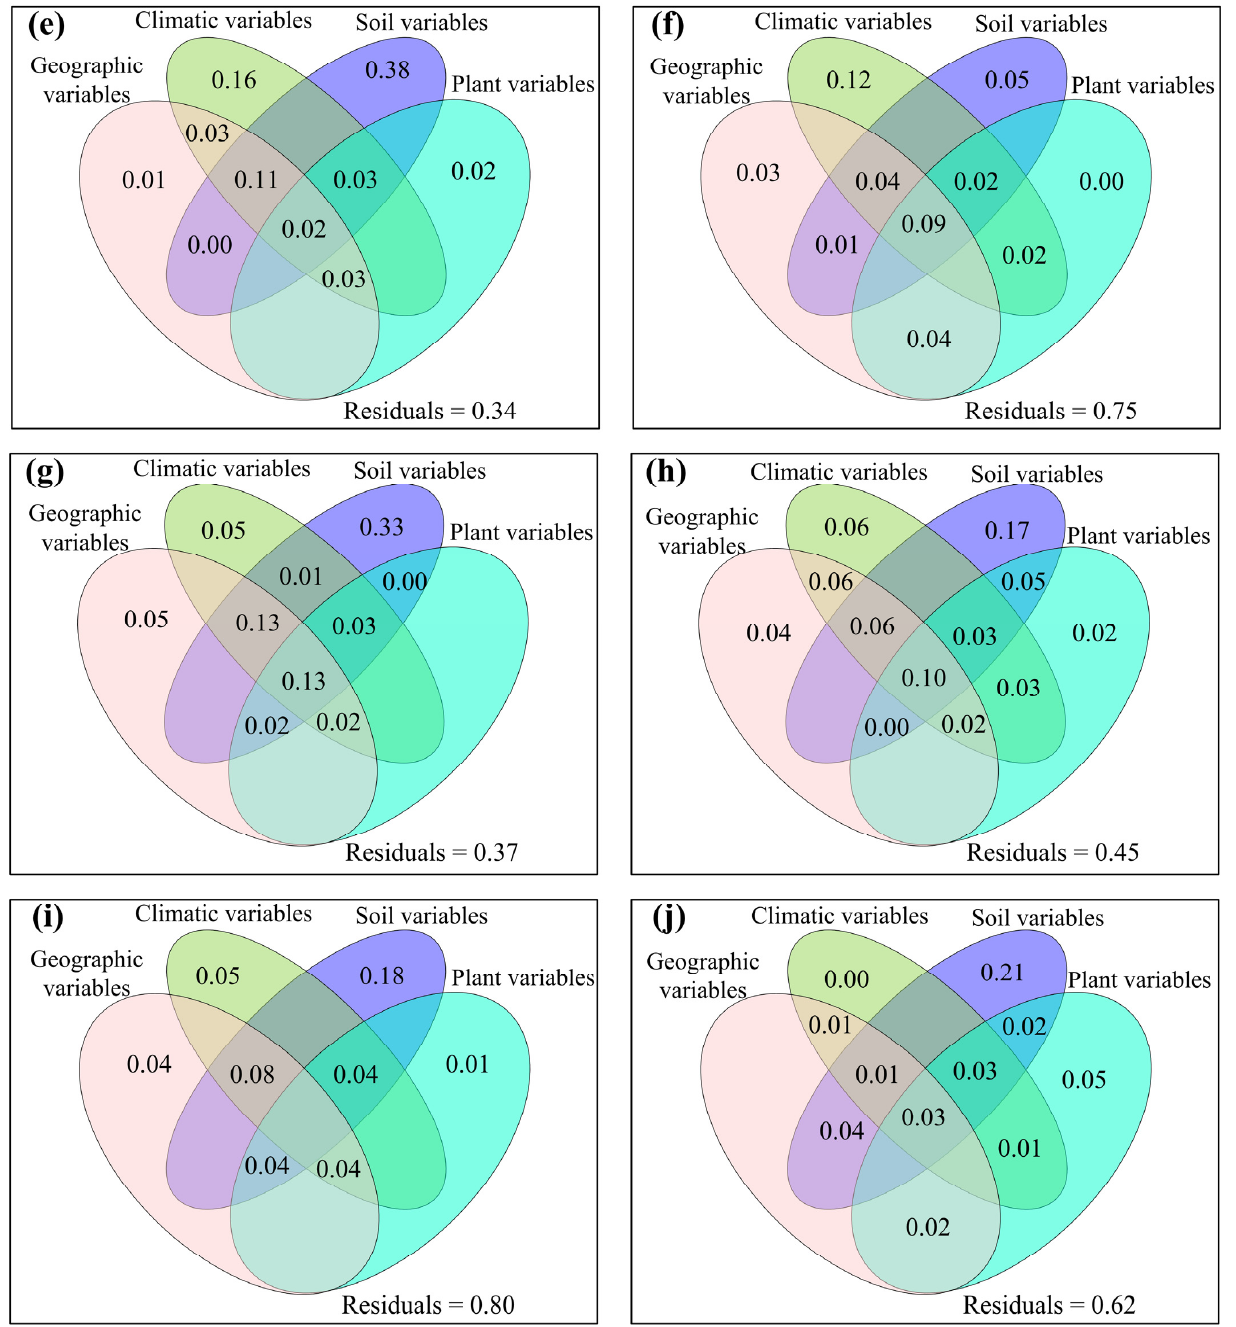
Figure 6. The mutual as well as excluded impacts of geographic variables, climatic variables, soil variables and plant variables on ( a , b ) operational taxonomic units (OTU s ), ( c , d ) Chao1 s , ( e , f ) ACE s , ( g , h ) Shannon s and ( i , j ) Simpson s of soil fungal community for ( a , c , e , g , i ) topsoil and ( b , d , f , h , j ) sub- topsoil, respectively.